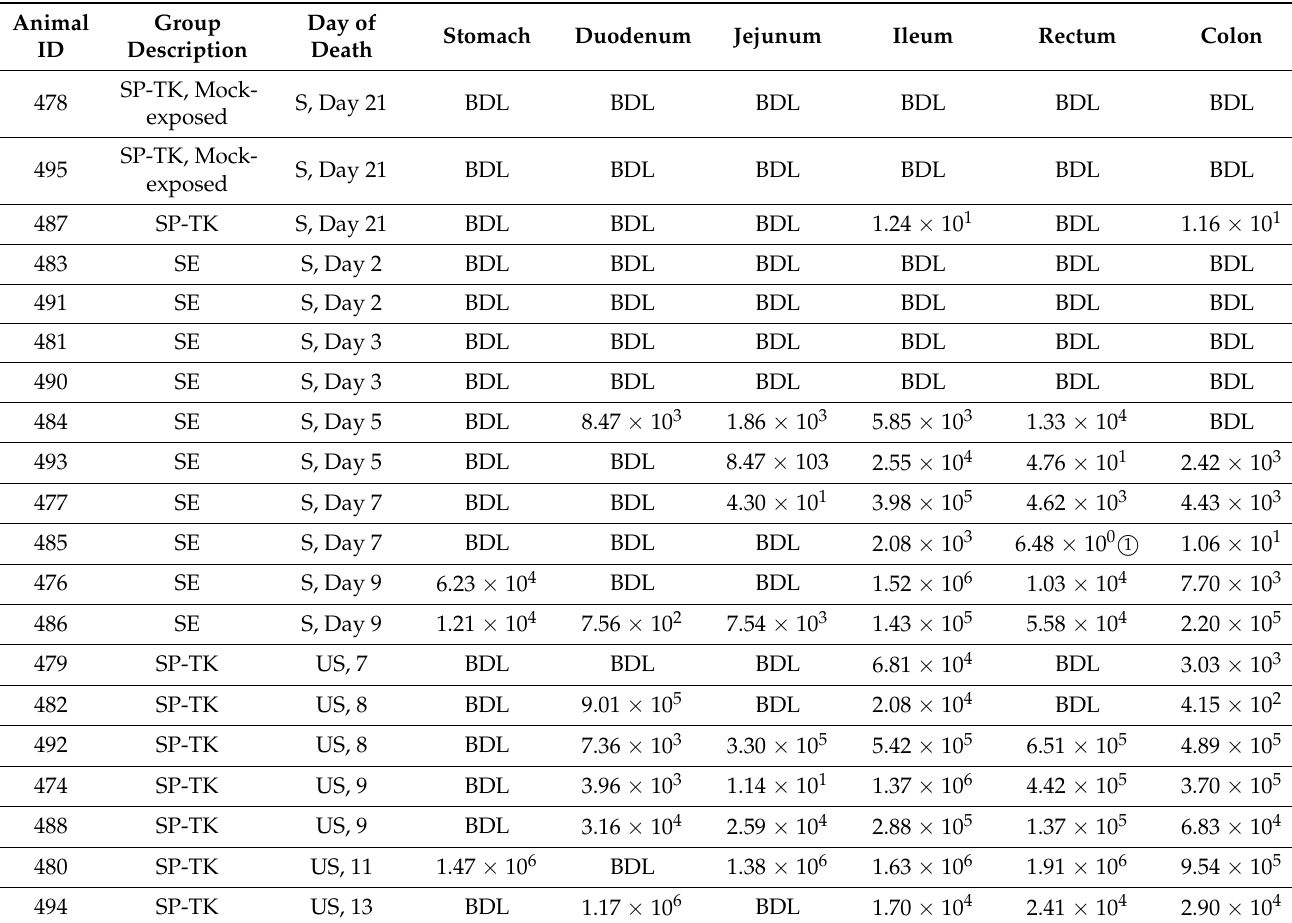
Table 5. Viral Load in Gastrointestinal Tract Tissues as Determined by qRT-PCR Assay (GE/ µ g total